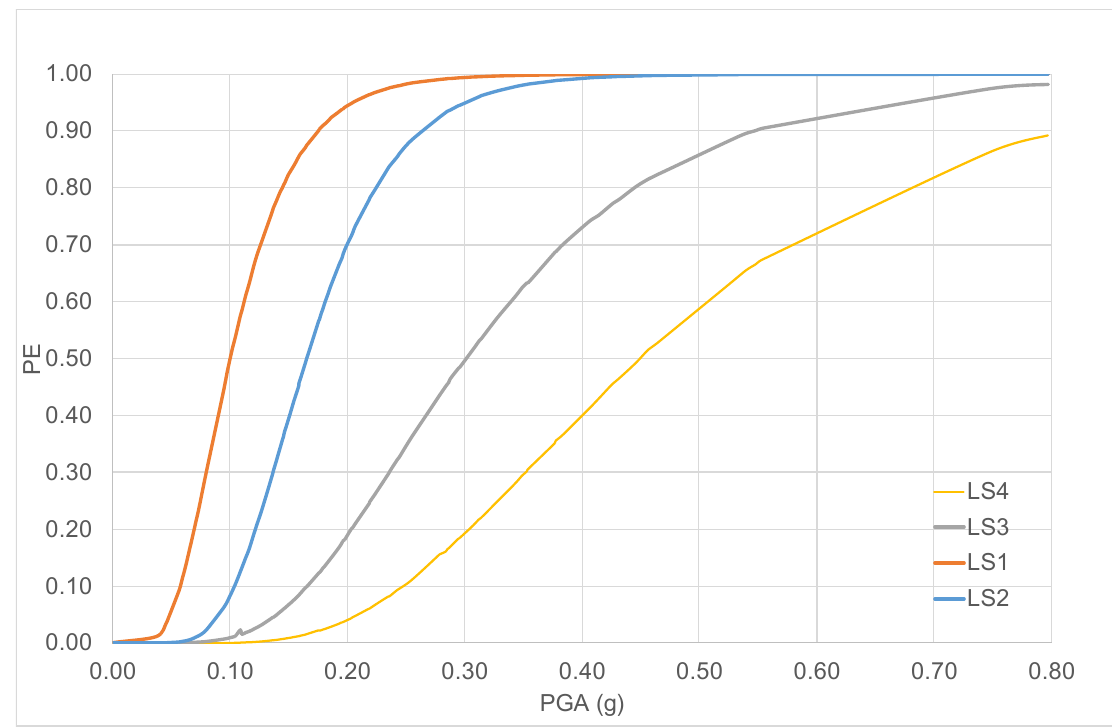
Figure 14. Fragility curves for the structure (top-floor drift).